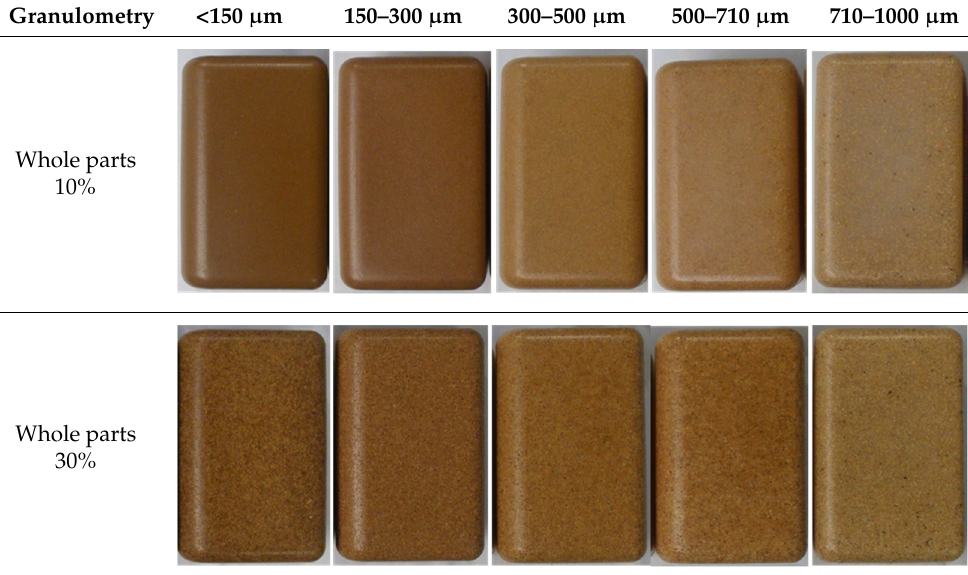
Table 3. Images of parts produced by MDPE/wood composites using 10 and 30% of each wood granulometry.